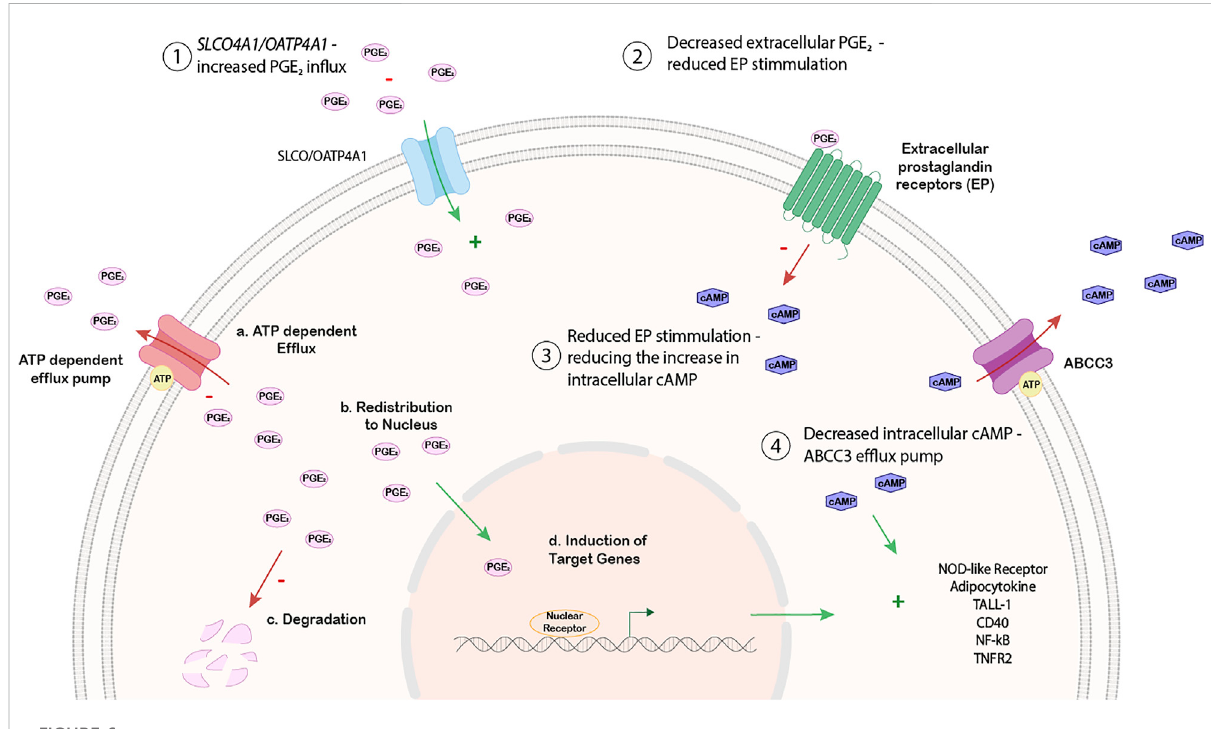
FIGURE 6 Working hypothesis on the relationship between SLCO4A1 expression and NF-kB associated